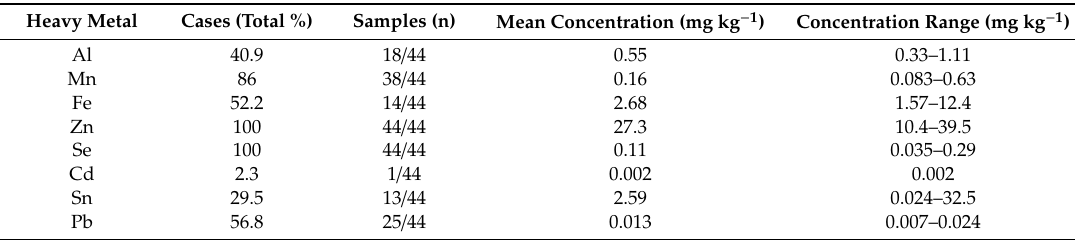
Table 5. The concentrations of heavy metals found in blue cheese